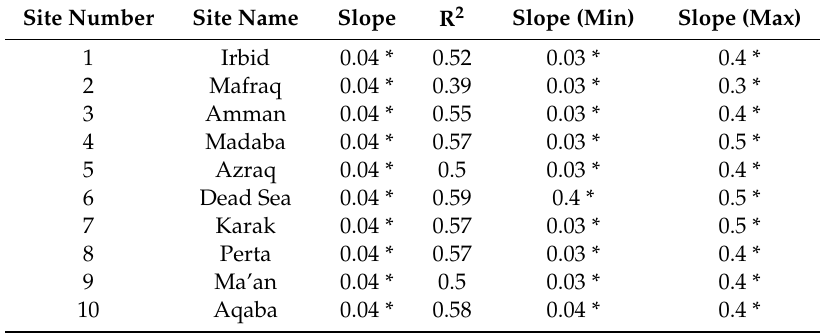
Table 4. Mann–Kendal trend test predicted by Sen’s slope estimator for yearly mean air temperature during 1979–2018.